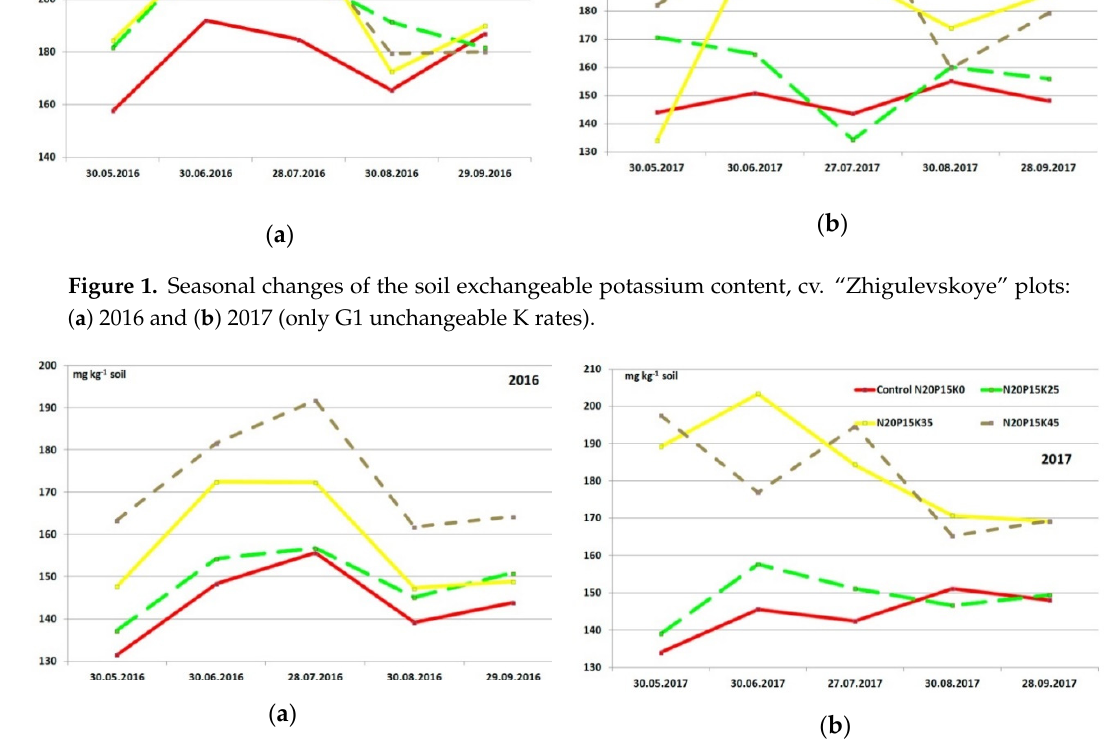
Figure 2. Seasonal changes of the soil exchangeable potassium content, cv. “Lobo” plots: ( a ) 2016 and ( b ) 2017 (only G1 unchangeable K rates).